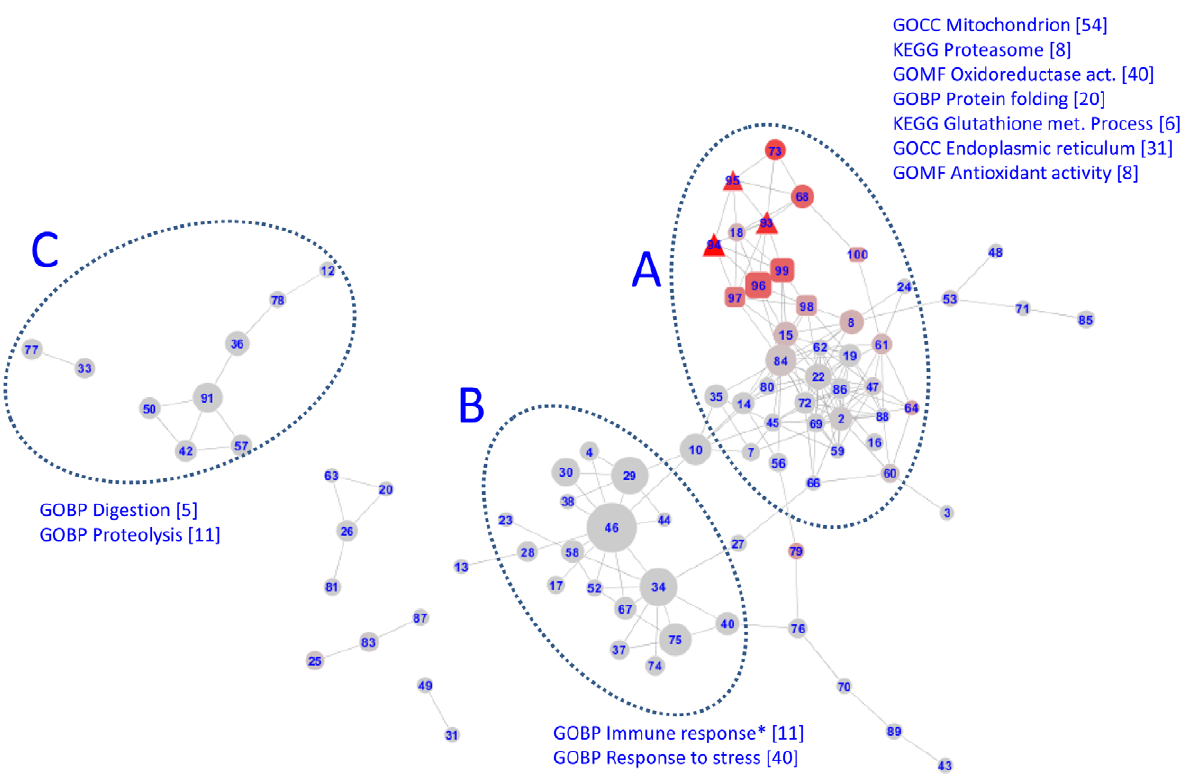
Figure 2. The network of modules that represents the flounder liver molecular state. Modules (consisting of transcripts, metabolite bins and morphological measurements) are numbered; sizes are proportional to the number of nodes within each module. Red colouring is proportional to the percentage of each module that consisted of metabolite bins. Modules whose seeds were transcripts are shown as circles; metabolites as triangles; morphological measurements as squares. Annotation terms significantly enriched (FDR , 0.05 by DAVID) in areas of the network are shown (*=not statistically significant).